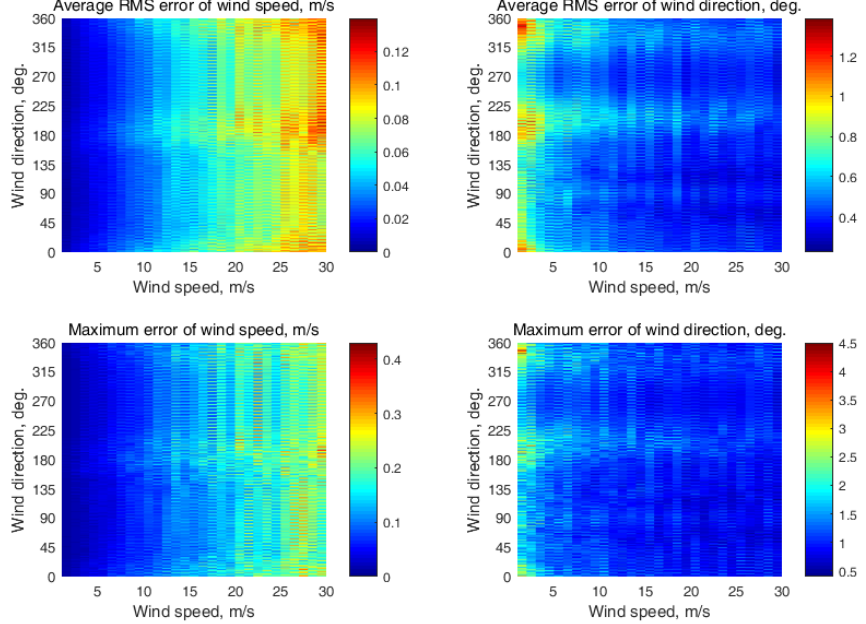
Figure A19. Semicircular wind retrieval results at the (50°, 55°, 60°) incidence angle